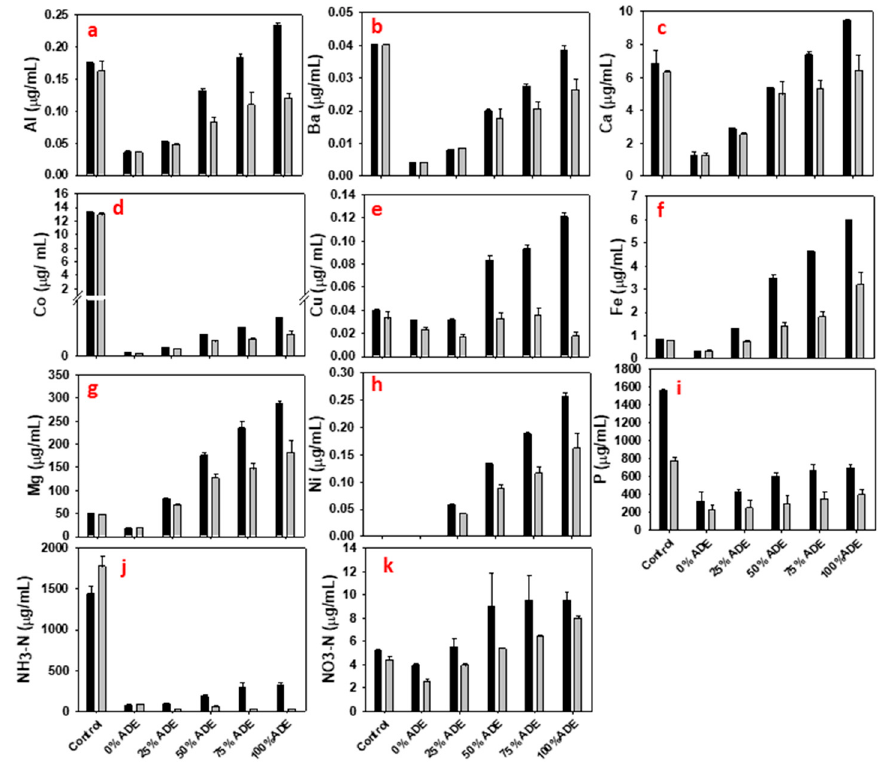
Figure 2. Concentrations of aluminum, barium, calcium, cobalt, copper, iron, magnesium, nickel, phosphorus, ammonia, and nitrate ( a – k ) in ADE cultures of P. polymyxa at 0 h (black color) and at the end of fermentation (gray color). Table 4. Fermentation parameters of P. polymyxa grown in treatment A media containing ~115 g/L glucose supplemented with anaerobic digestion effluent (ADE).